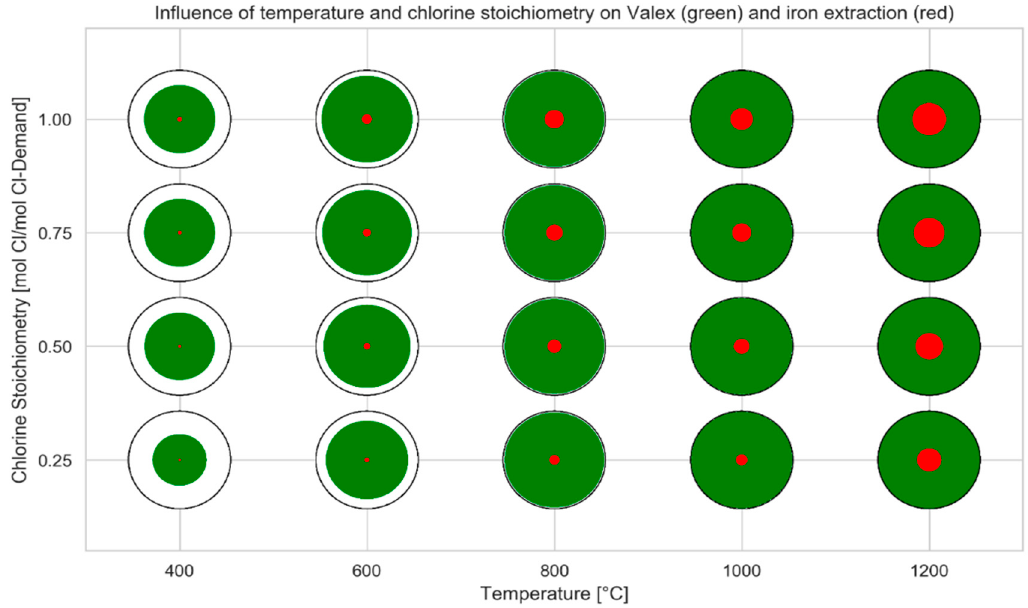
Figure 5. Influence of temperature and chlorine stoichiometry on mean valex (green) and iron extraction (red) including all previously stated parameters; the black circle represents a value of 1.00 .